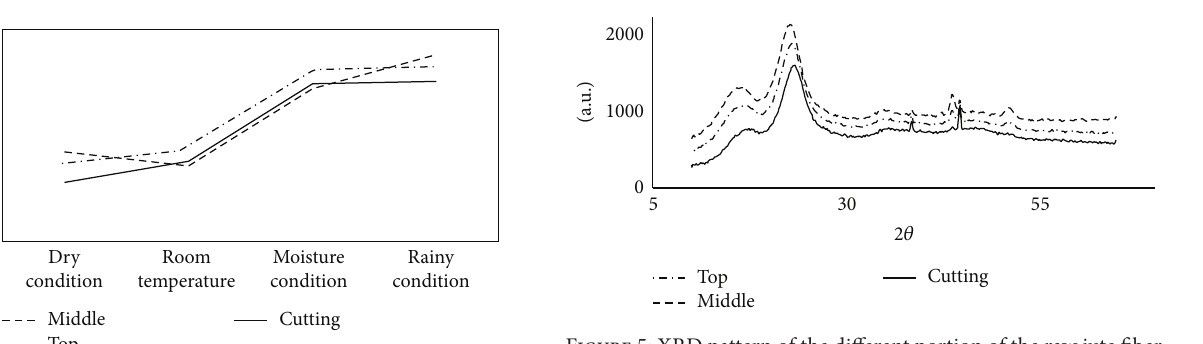
Figure 5: XRD pattern of the different portion of the raw jute fiber. thermogravimetric analysis, X-ray diffraction analysis, and scanning electron microscopy on top, bottom, and cutting portions of jute fiber were carried out. The middle portion had higher tensile strength, strain to failure, and Young’s modulus as compared to top and cutting portions. The surface of the cutting portion was rougher as compared to